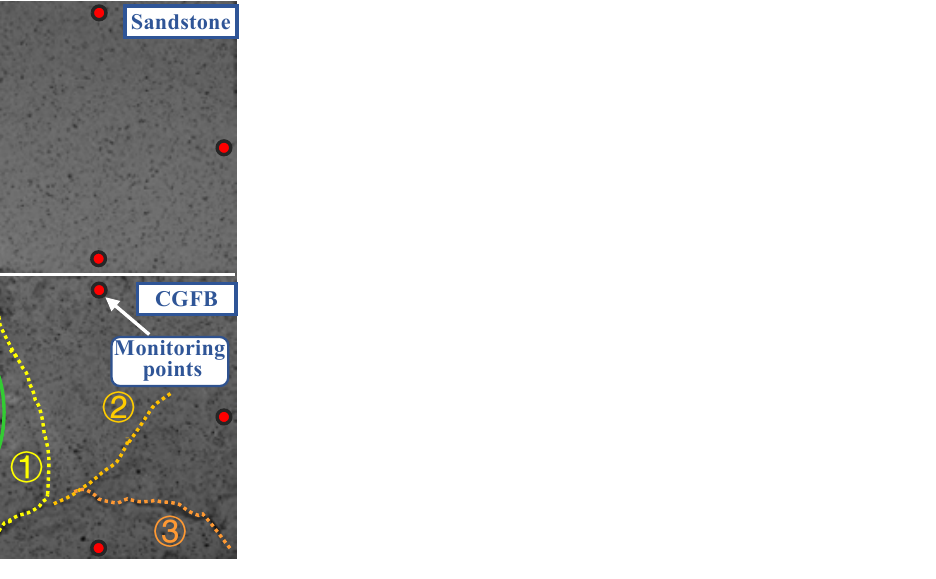
Figure 19. Layout of monitoring points at the boundary of sandstone–CGFB composite samples.